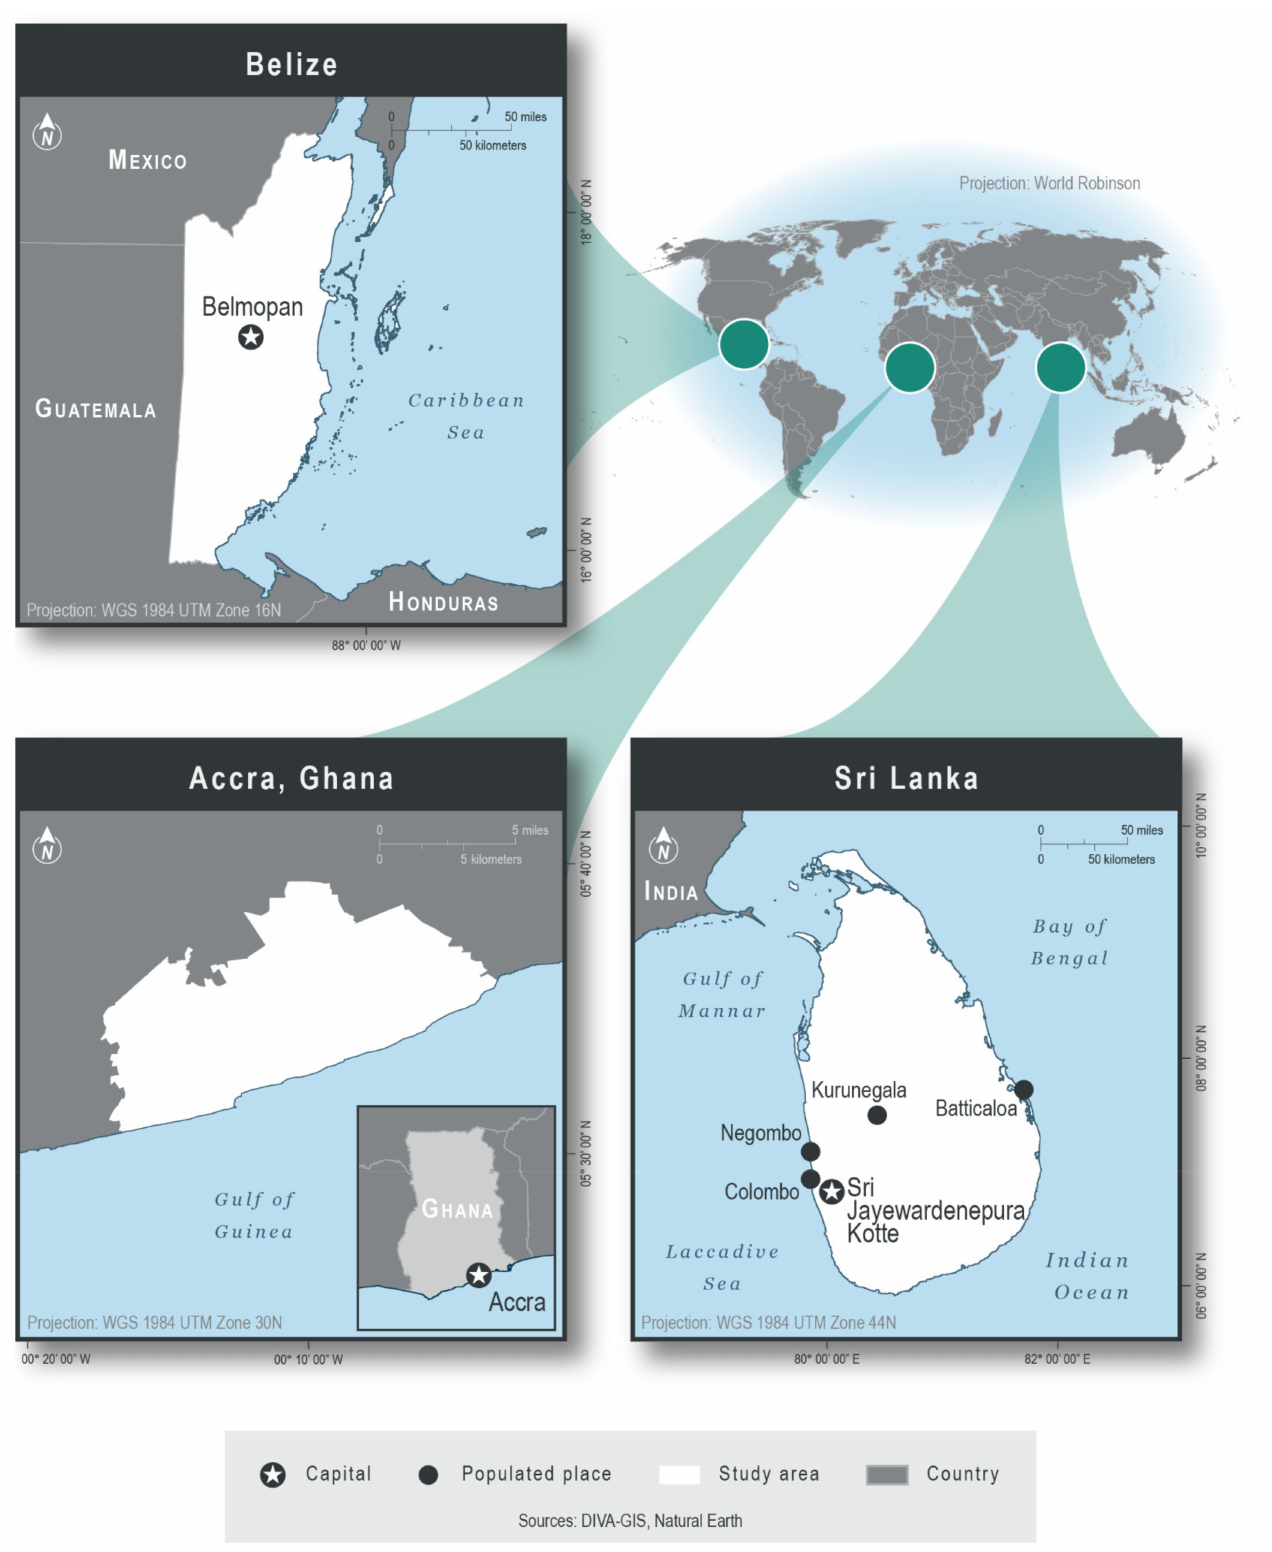
Figure 2. Study areas consisting of the countries of Belize and Sri Lanka and the city of Accra, Ghana. Sources: